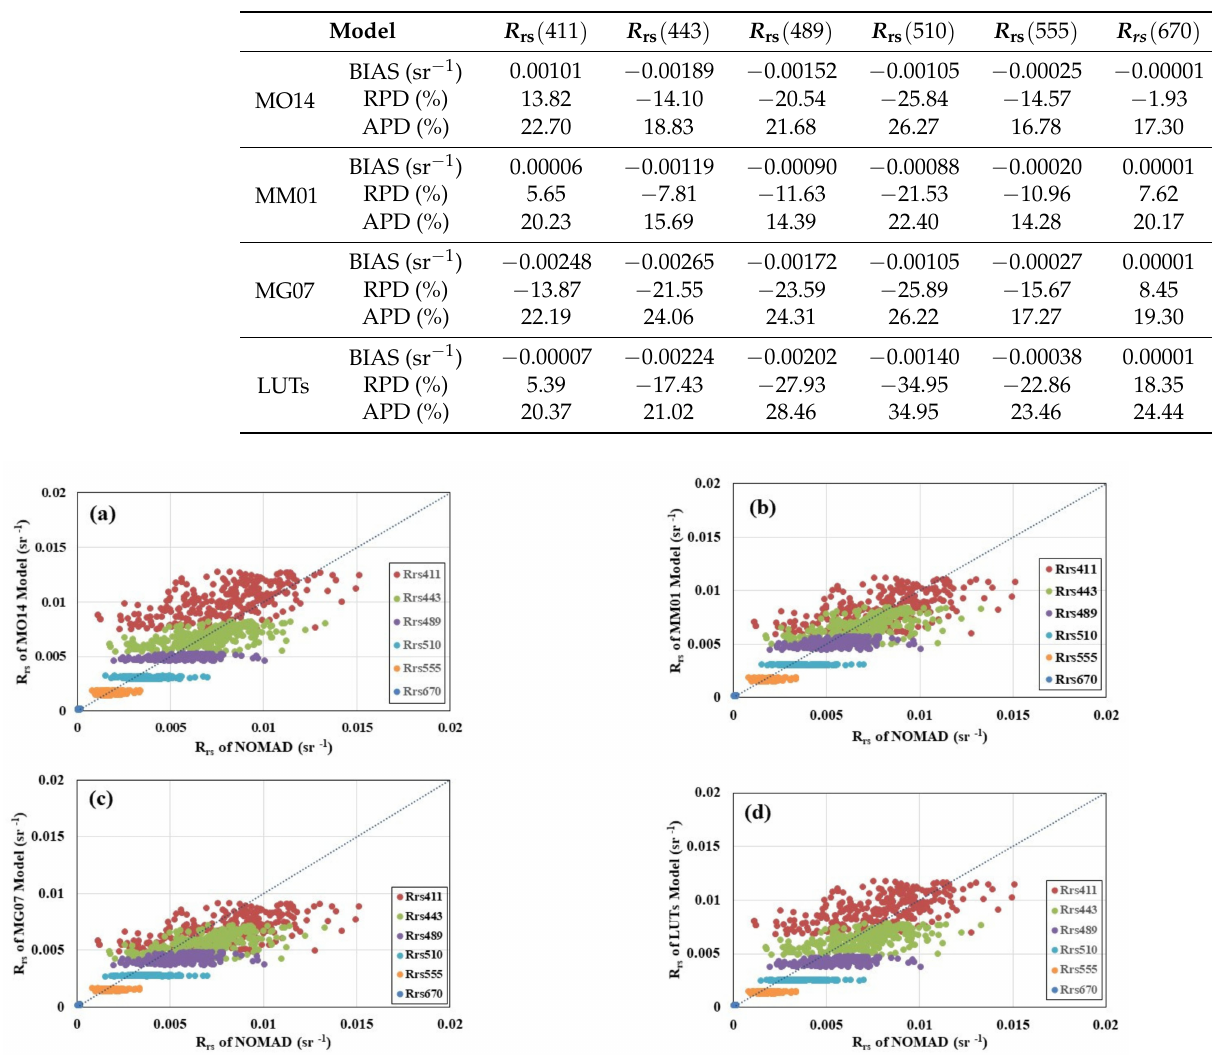
Table A1. Statistical parameters of MM01, MG07, MO14, and LUTs models in oligotrophic ocean.